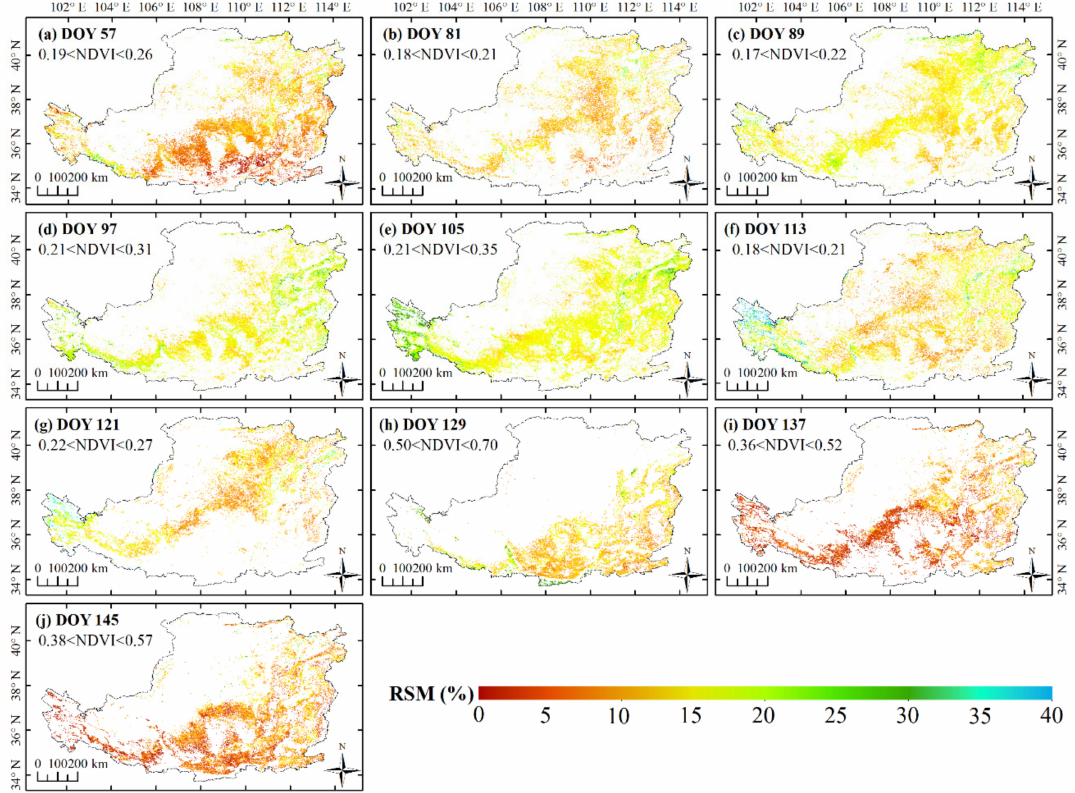
Figure 11. Spatiotemporal patterns of the relative soil moisture in the spring of 2017. ( a ) DOY 57 for 0.19 < NDVI < 0.26 using the ATI / TVDI joint model, ( b ) DOY 81 for 0.18 < NDVI < 0.21 using the ATI / TVDI joint model, ( c ) DOY 89 for 0.17 < NDVI < 0.22 using the ATI / TVDI joint model, ( d ) DOY 97 for 0.21 < NDVI < 0.31 using the ATI / TVDI joint model, ( e ) DOY 105 for 0.21 < NDVI < 0.35 using the ATI / TVDI joint model, ( f ) DOY 113 for 0.18 < NDVI < 0.21 using the ATI / TVDI joint model, ( g ) DOY 121 for 0.22 < NDVI < 0.27 using the ATI / TVDI joint model, ( h ) DOY 129 for 0.50 < NDVI < 0.70 using the ATI / TVDI joint model, ( i ) DOY 137 for 0.36 < NDVI < 0.52 using the ATI / TVDI joint model, ( j ) DOY 145 for 0.38 < NDVI < 0.57 using the ATI / TVDI joint model.